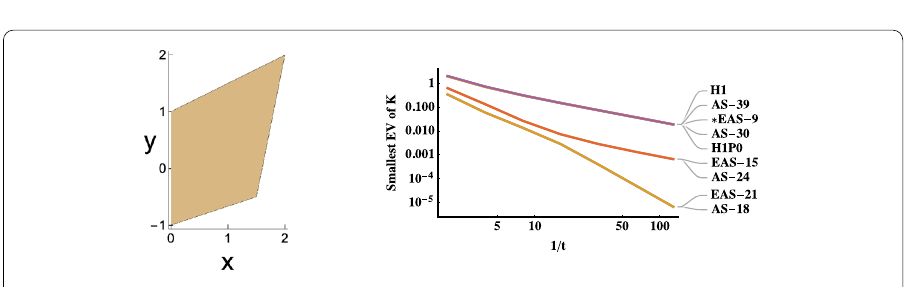
Fig. 5 Investigation of eigenvalue spectrum; domain and related eigenmode depicted on the left. Development of smallest eigenvalue over 1 / t on the right